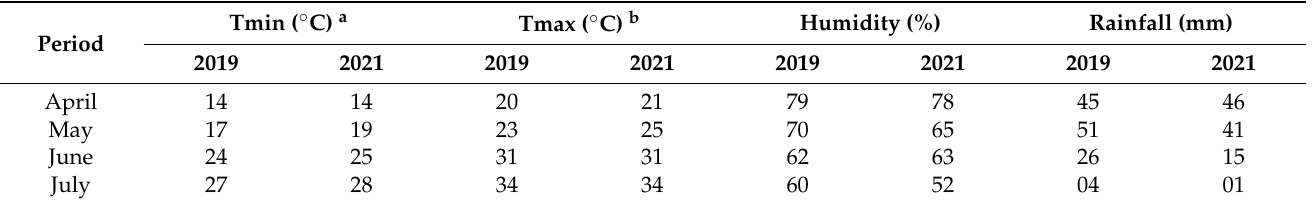
Table 1. Climate data recorded for the same season during the growing of tomatoes for the years 2019 and